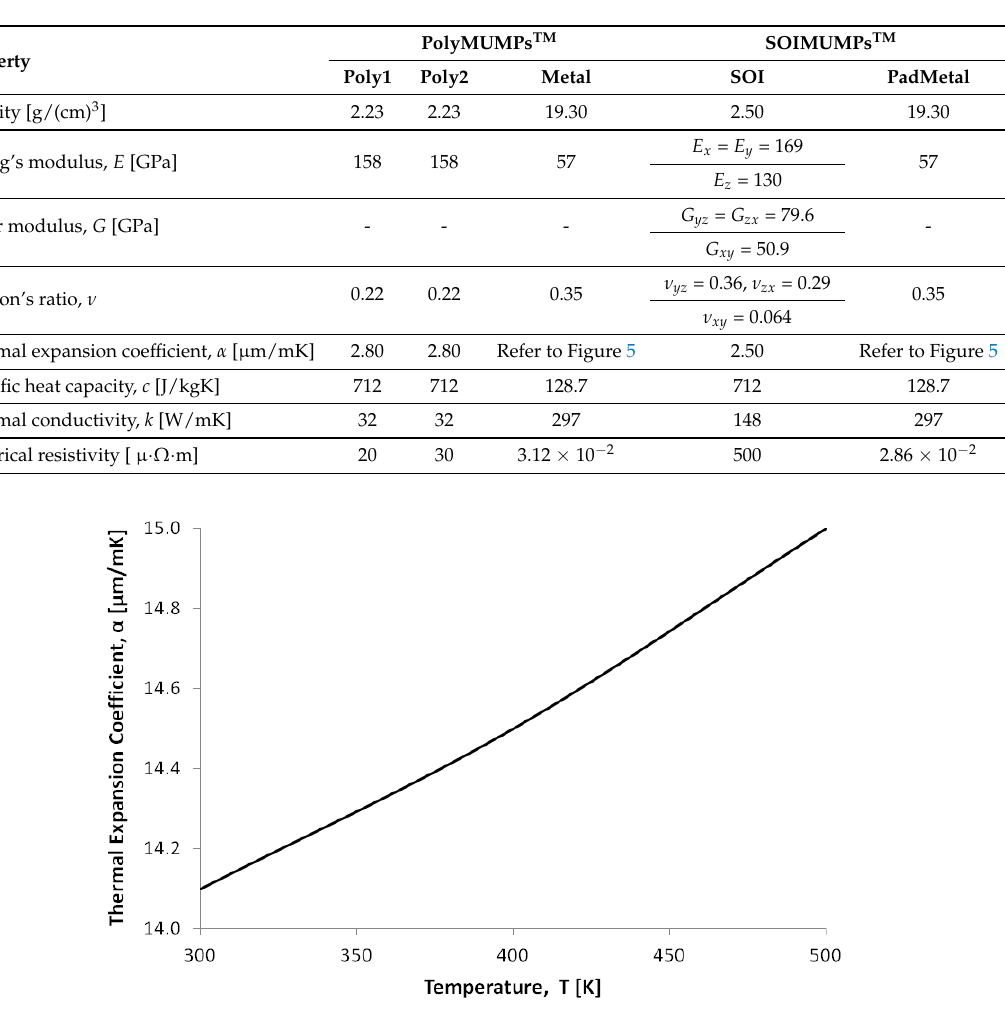
Figure 5. Variation of the coefficient of thermal expansion, α , with temperature for the Metal and PadMetal Layers in the PolyMUMPs TM [39] and SOIMUMPs TM [40] processes,